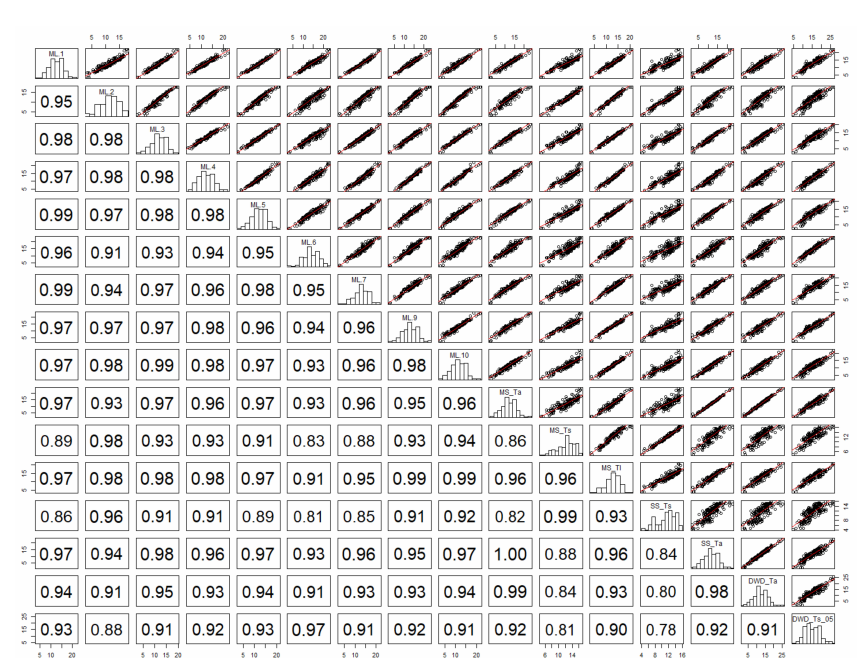
Figure A2. Spearman correlation matrix of daily temperature averages including the surface-near measurements of the Micro-Logger (ML1 to ML10) and Medium Station (Tl), air temperature (Ta) of the Medium and Small Stations at “small clearing” and the official weather station (DWD) as well as soil temperature (Ts) in 5 cm depth. The lower triangle shows the coefficient of determination ( R 2 ), the upper triangle the scatterplots and linear regression fit lines (red) and the diagonal the histograms.